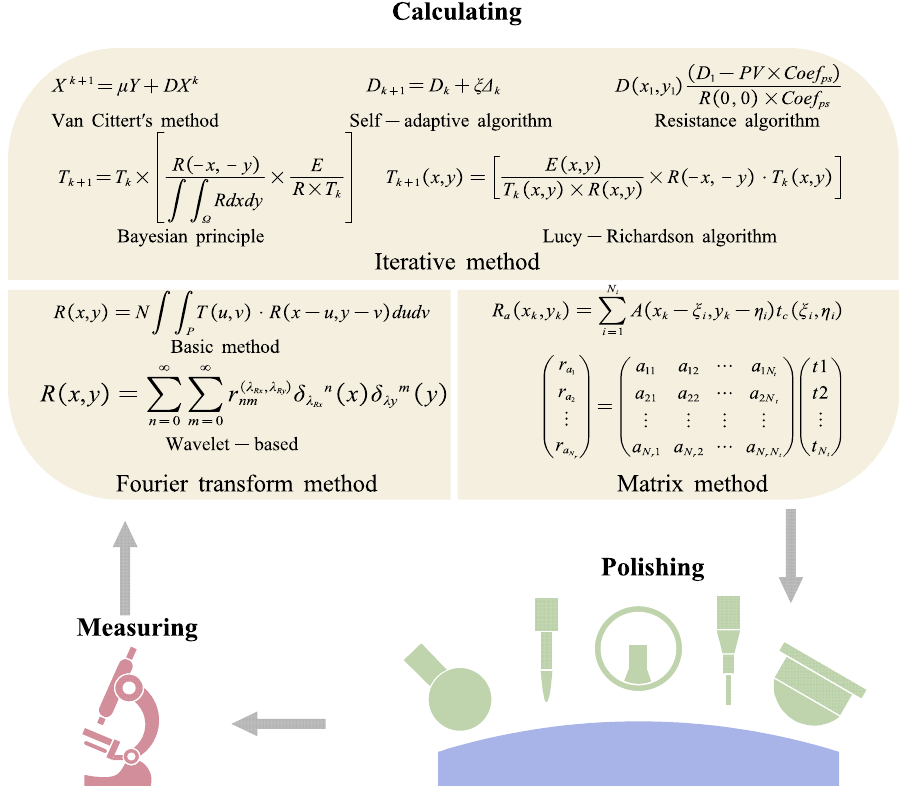
Figure A1. The process flow of the polishing workpiece using computer-controlled optical surfacing. Figure A2 shows the CCOS polishing process in detail. The polishing head polishes point by point along the planned tool path on the workpiece surface. The envelope line of the removal function forms the final workpiece surface profile [267].